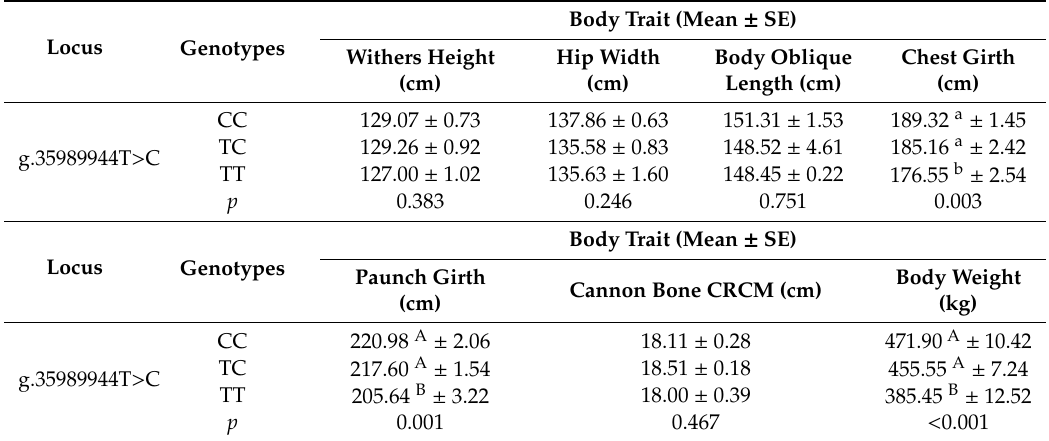
Table 5. Association between the KCNJ12 variation and cattle stature in Xia’nan (XN) cattle.